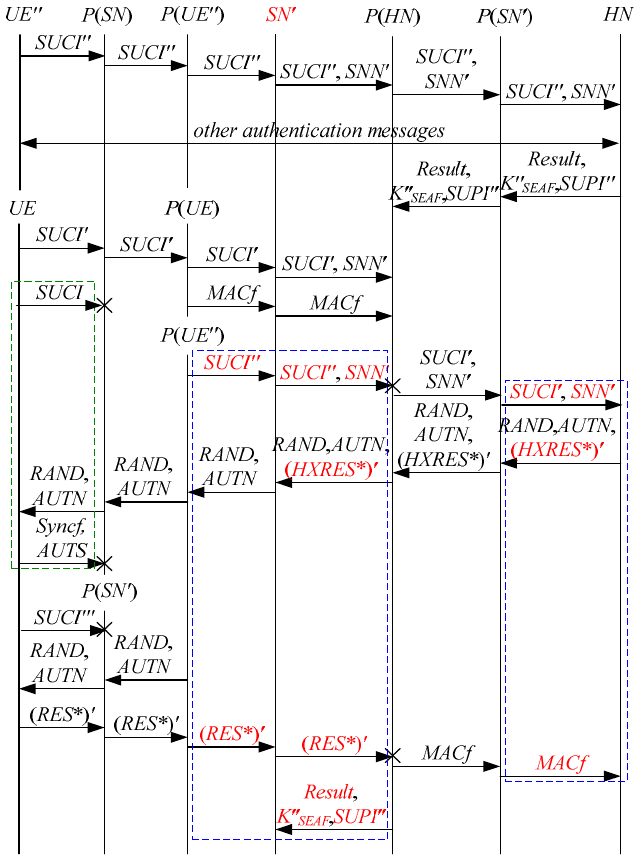
Figure 8. The seventh attack scenario of the 5G AKA protocol.